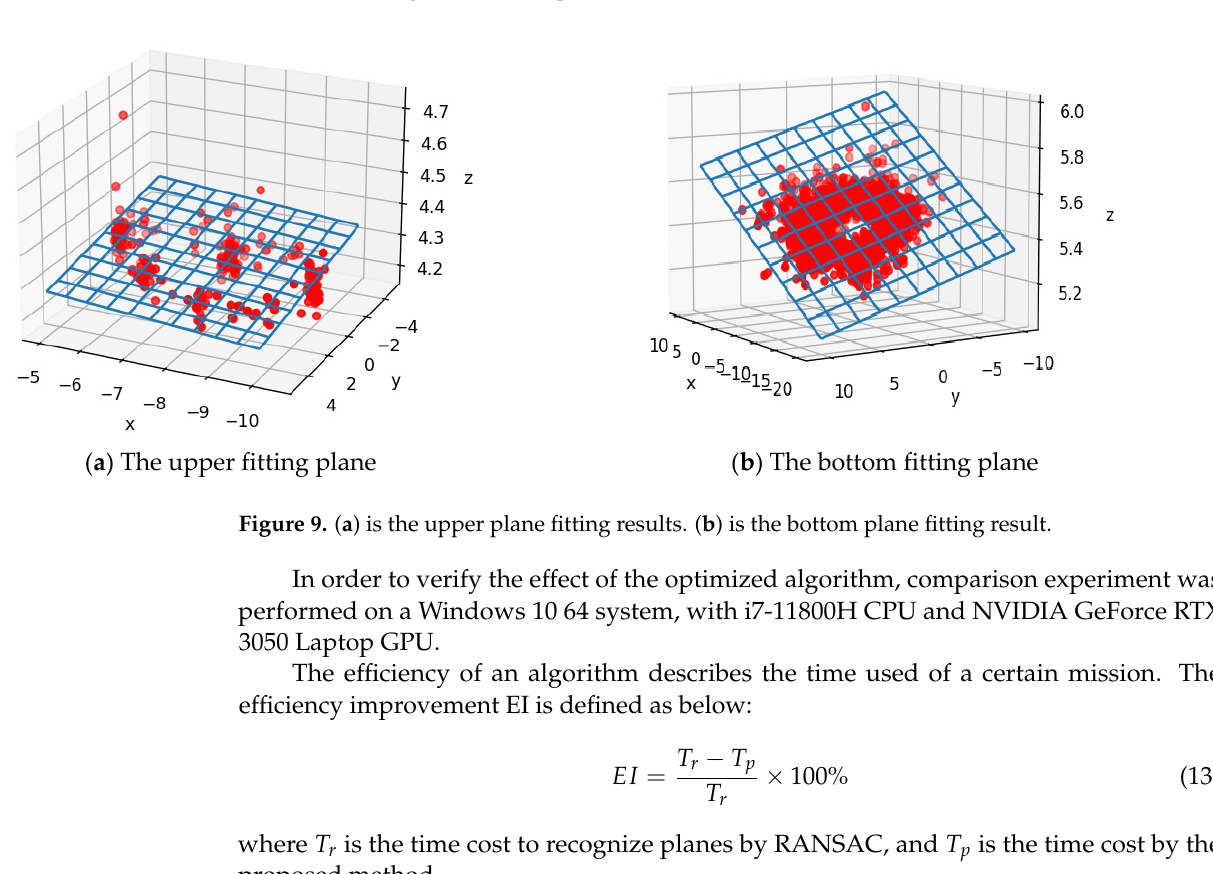
Figure 8. The height data of the point cloud.